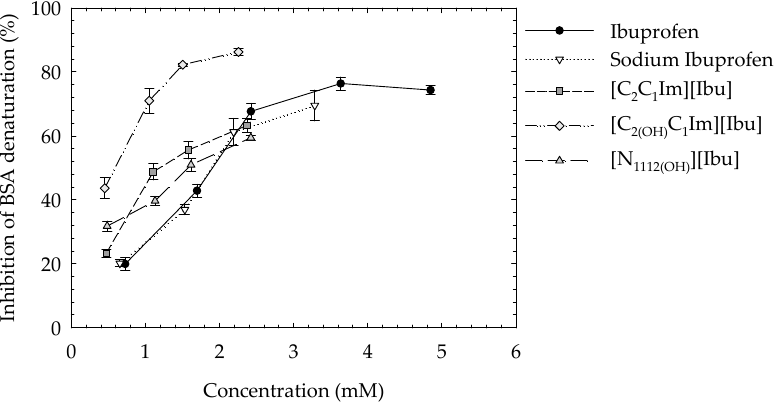
Figure 3. Inhibition profile of BSA denaturation by ibuprofen, ibuprofen sodium salt, [C 2 C 1 Im][Ibu], [C 2(OH) C 1 Im][Ibu] and [N 1112(OH) ][Ibu].